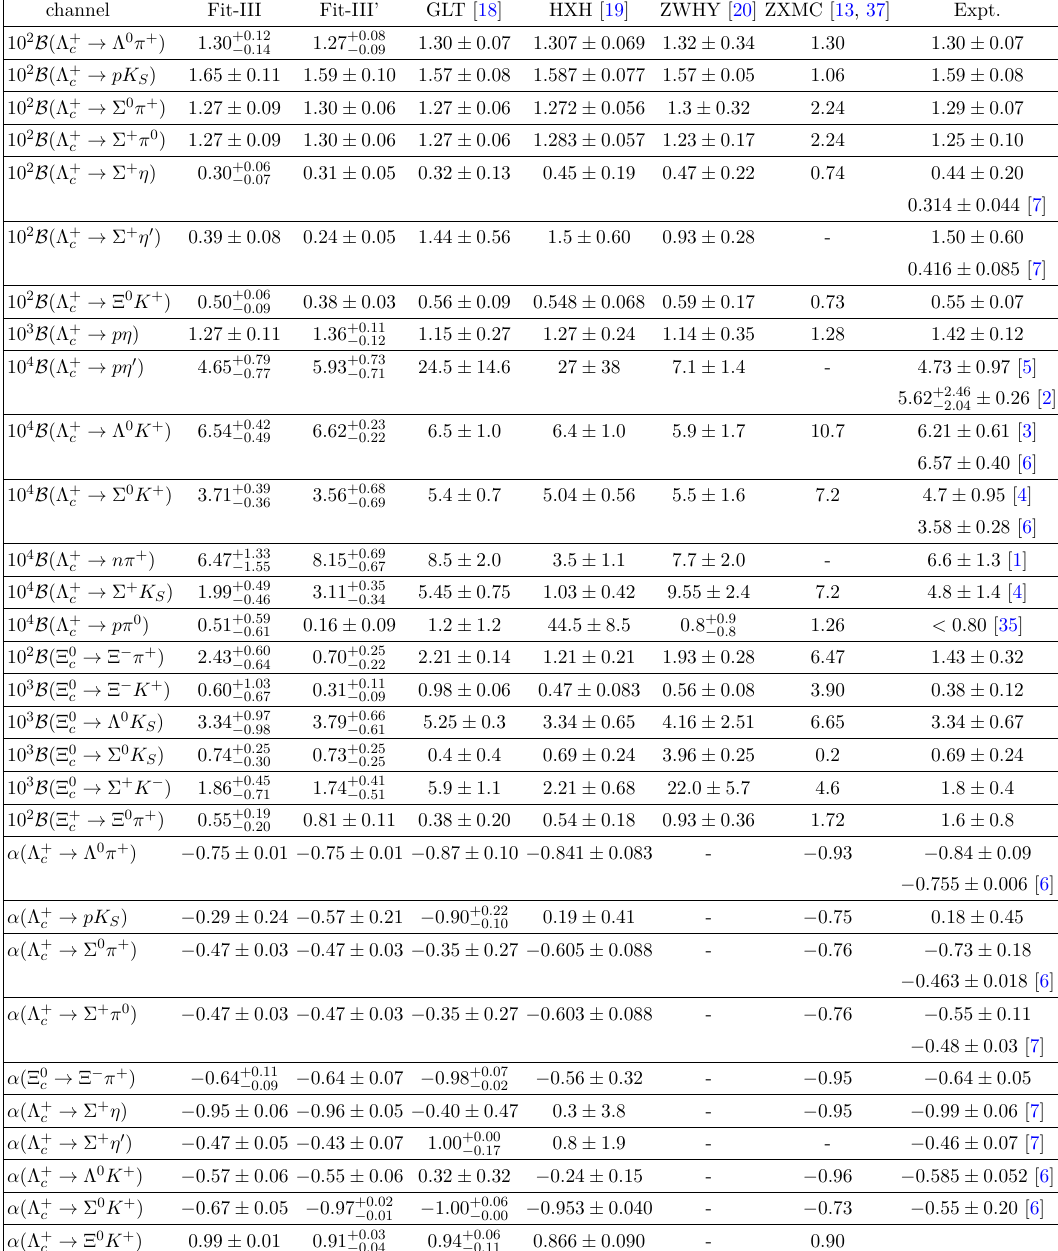
Table 8 . The comparison of theoretical predictions for branching fractions and decay asymmetries in different methods and the latest measured experimental